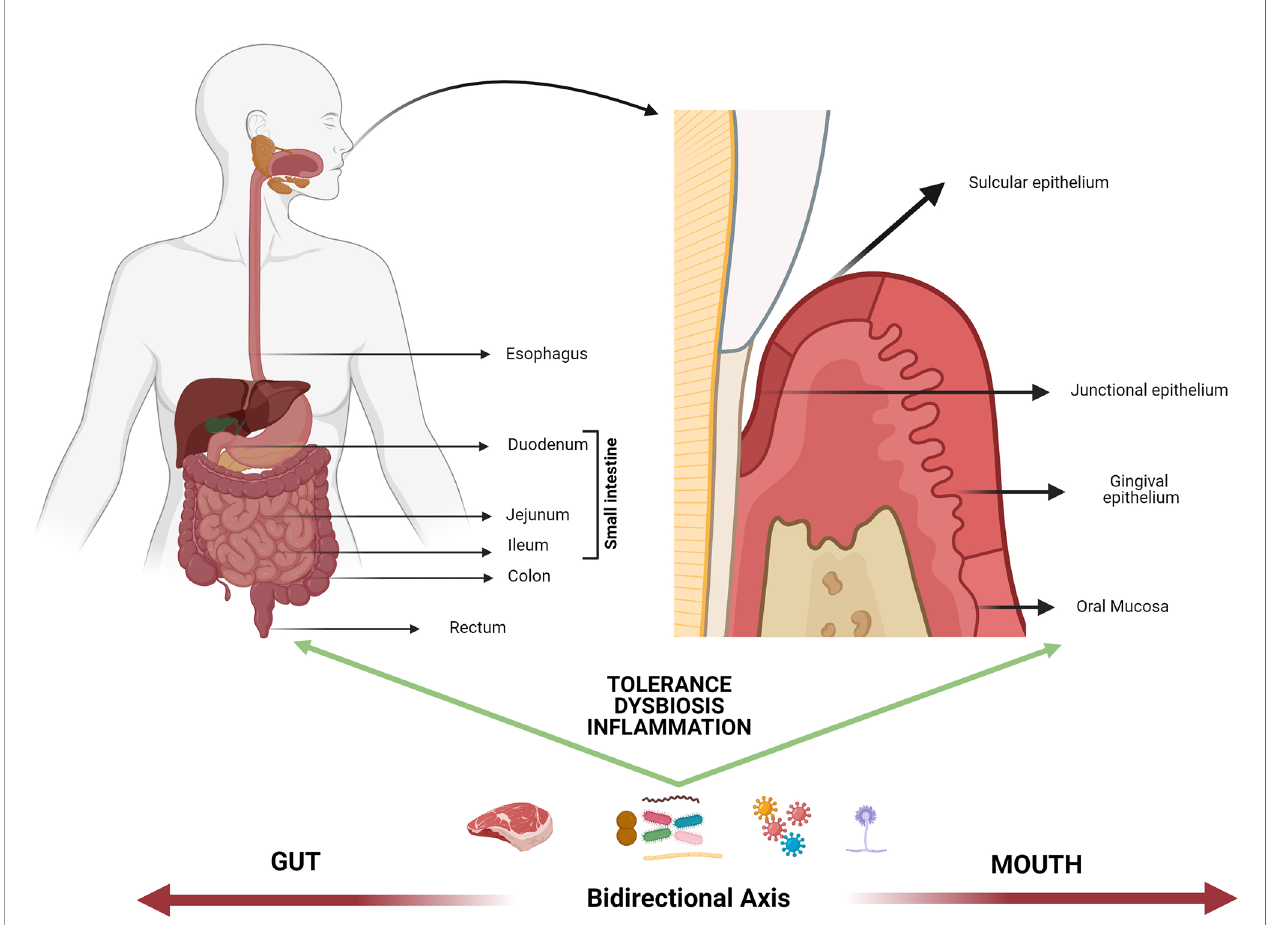
FIGURE 1 | Mouth-gut axis. The plausible interrelation between the oral cavity and the rest of the gastrointestinal system could be mainly mediated by the response to potentially harmful self and/or foreign antigens (i.e., food, allergens, microbiome, trauma), extending beyond the control of tolerance mechanisms. Such mechanisms operate differently based on epithelia diversity of the mouth-gut axis and the direct interaction between the oral/intestinal microbiota and the host immune response, nonetheless they are thought to operate in the same immune continuum. The dysbiosis of microbial communities at both levels as well as the atopobiosis of microorganisms from the oral cavity to the intestine is seen today as a determining factor in the course of multiple in fl ammatory